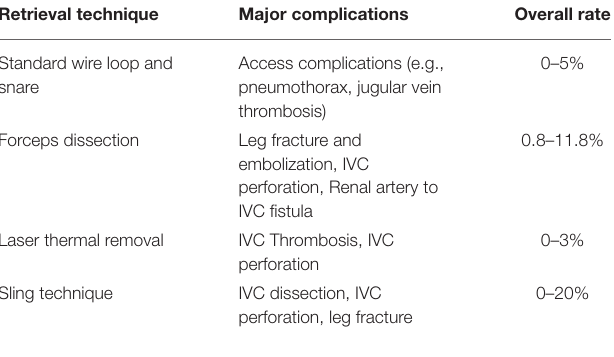
TABLE 3 | Major complication of IVCF retrieval and their reported rate stratified by the technique used. Retrieval technique